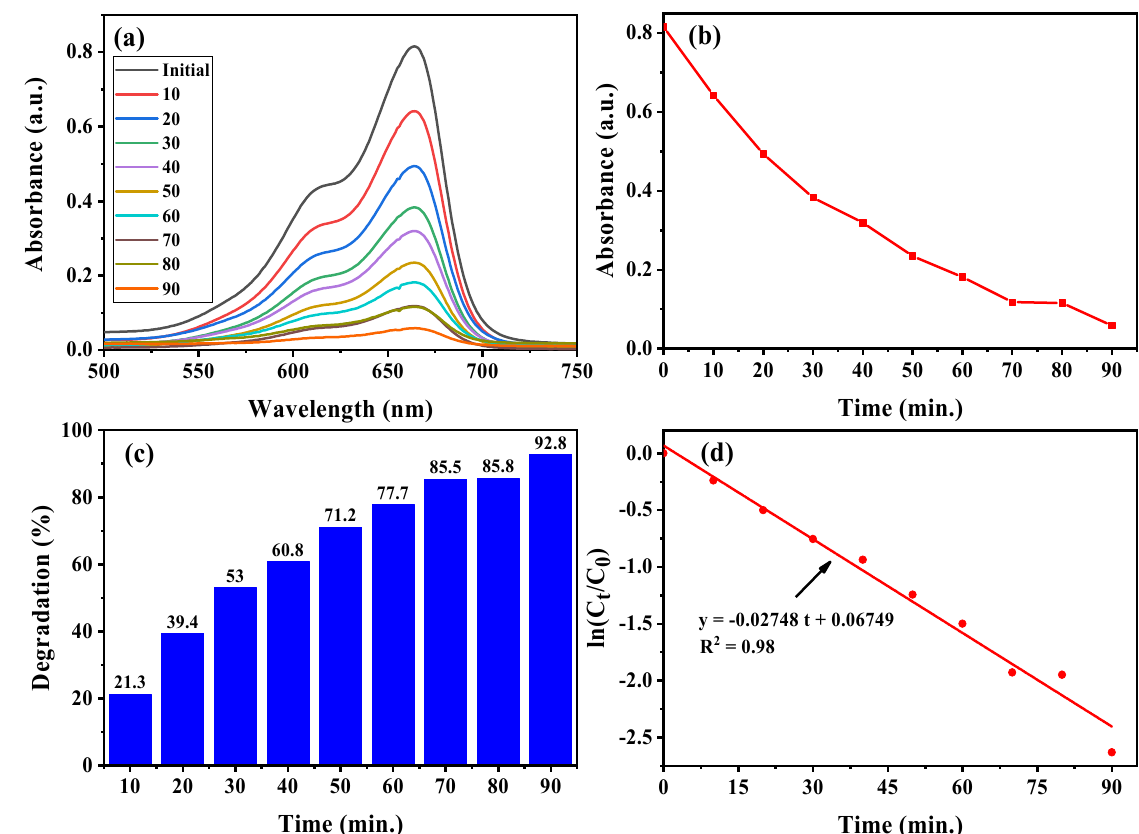
Figure 7. Change of absorbance with time ( a , b ), degradation achieved ( c ), and pseudo-first-order kinetics plot ( d ) for the degradation of MB under visible light for 90 min. using the synthesized rGO-CuO